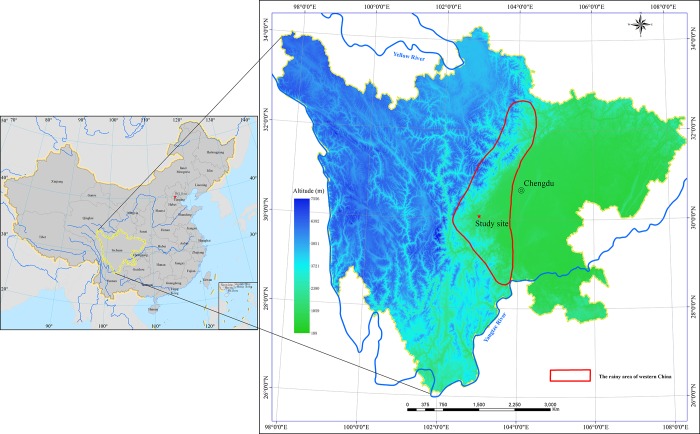
Locations of the rainy area of western China and the study site.The map was generated with ArcGIS version 10.0 (ESRI, Redlands, CA, USA, http://desktop.arcgis.com/en/arcmap/).